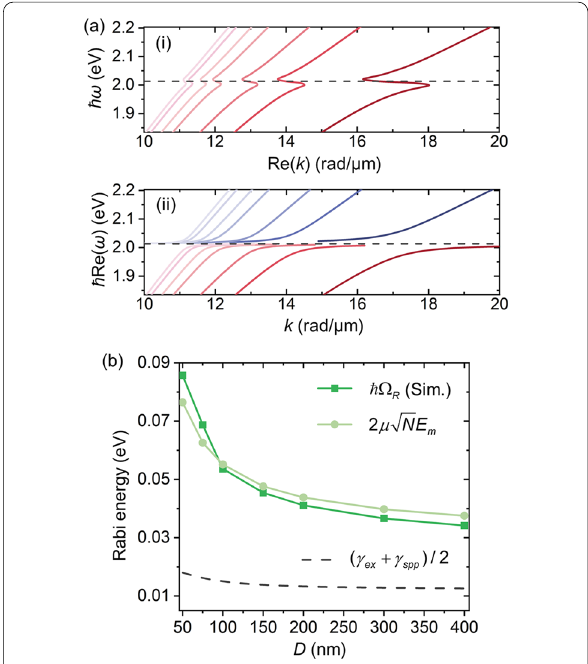
Fig. 5 Tunability in Rabi splitting energy ( ħ Ω R ) with tailored dispersions. a Dispersion relations in terms of ( i ) ħω versus Re( k ) and ( ii ) ħ Re( ω ) versus k by using the COM model with simulated parameters (see supporting information) with varied MNW diameter ( D ) of (from right to left, colors from dark to light) 50, 75, 100, 150, 200, 300, 400 nm, respectively, showing less profound back-bending features and smaller ħ Ω R with increasing diameters. Gray dashed lines: exciton resonance. b ħ Ω R versus D . The numerically obtained result (squared green line) coincides well with one calculated using Eq. (5) (dotted pale green line). Despite the reduced ħ Ω R , the strong coupling criterion is fulfilled for every diameter presented compared to the overall damping of the coupled system (gray dashed